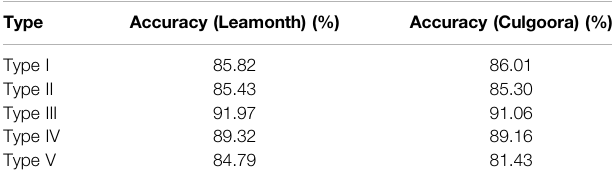
TABLE 2 | Accuracy of identi fi cation ofdifferent types of radio bursts according to the C-DCGAN